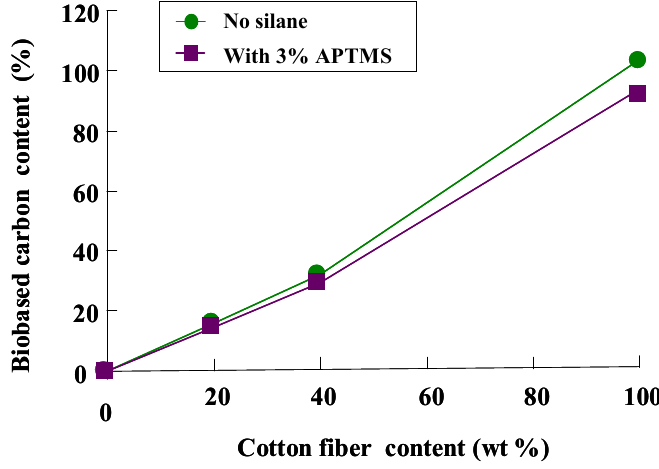
Figure 6. Biobased carbon content of PBS/CF composites as a function of CF